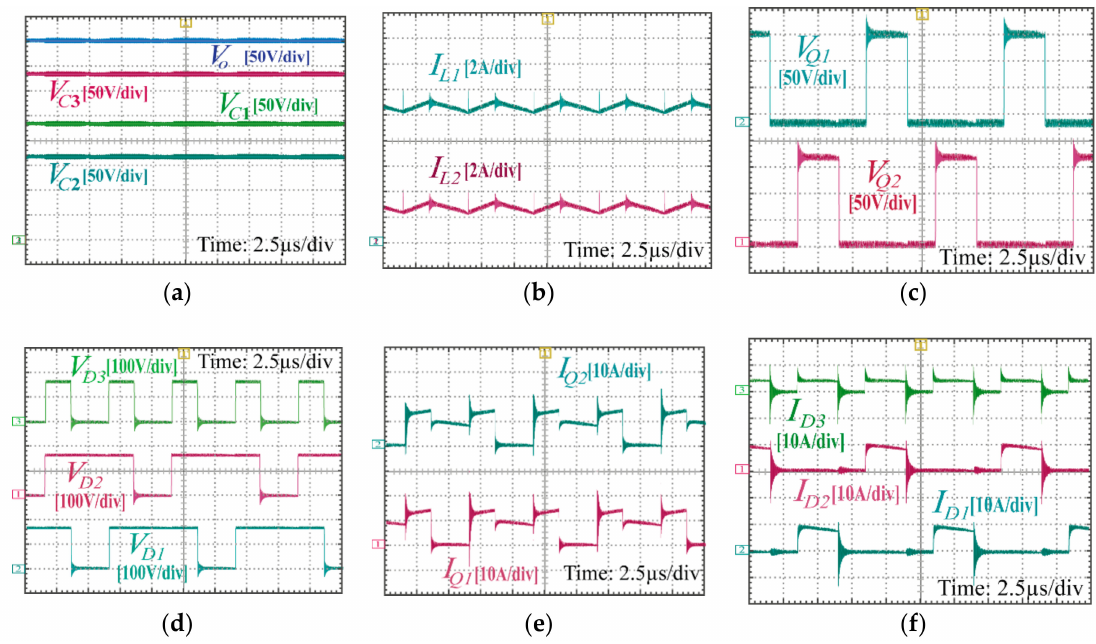
Figure 9. Experimental results when V in = 100 V, D = 0.7, R L = 120 Ω , P out = 1.3